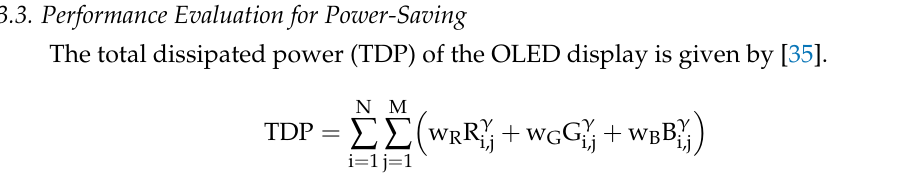
where i and j denote the horizontal and vertical indices of a pixel, respectively. N and M denote the numbers of the horizontal and vertical pixels, respectively. R, G, and B denote the RGB levels of the pixel (i, j). w R , w G , and w B , are the weighting coefficients and γ is the gamma value. They are panel-dependent coefficients. The used values of w R , w G , and w B and γ were 70, 115, and 154 and 2.2, respectively [4,35].